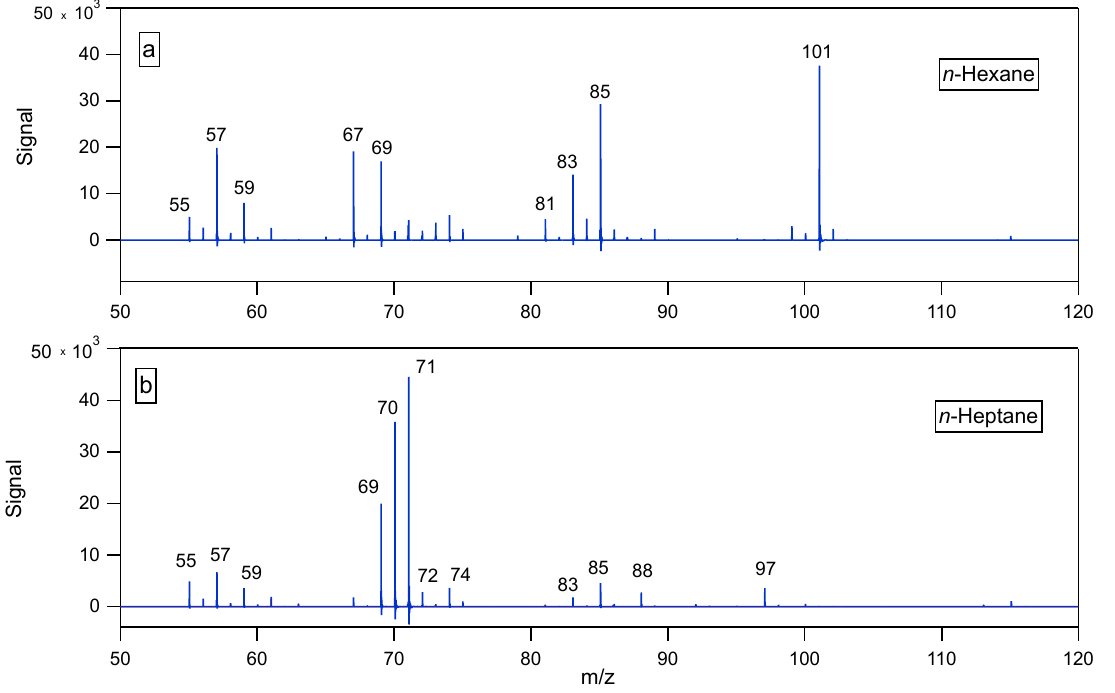
Figure 3. Mass spectra of: ( a ) n -hexane and ( b ) n -heptane measured with the new low-temperature plasma TOF MS equipped with an atmospheric pressure inlet.